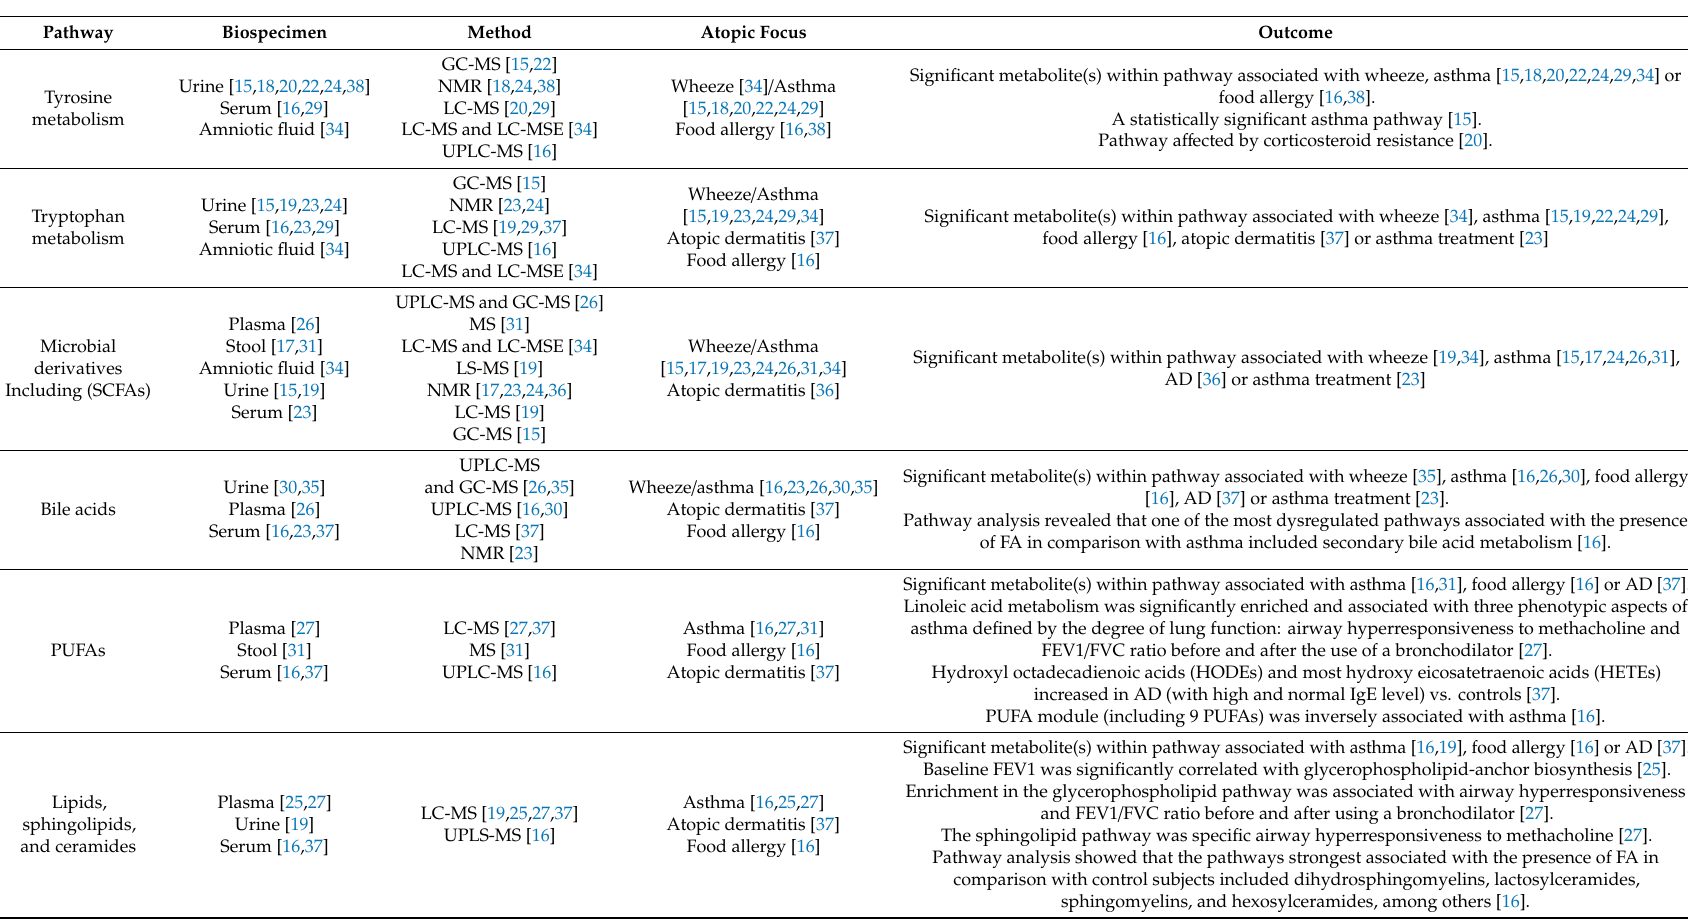
Table 3. Pathways of interest associated with asthma, allergy, or atopic dermatitis in more than one